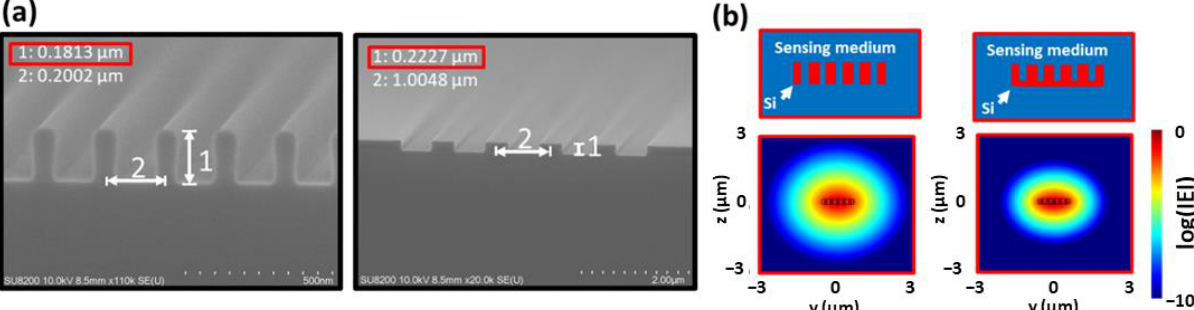
Figure 11. ( a ) Observed lag effect on a silicon wafer samples with grating periods of 200 nm ( left ) and 1 µm ( right ) with duty of 0.5 by inverse exposure method. ( b ) Schematic cross-sections of the MS WG and respective E-field profiles with fully etched ( left ) and not fully etched holes ( right ), with design parameters the same as in Figure 10e.